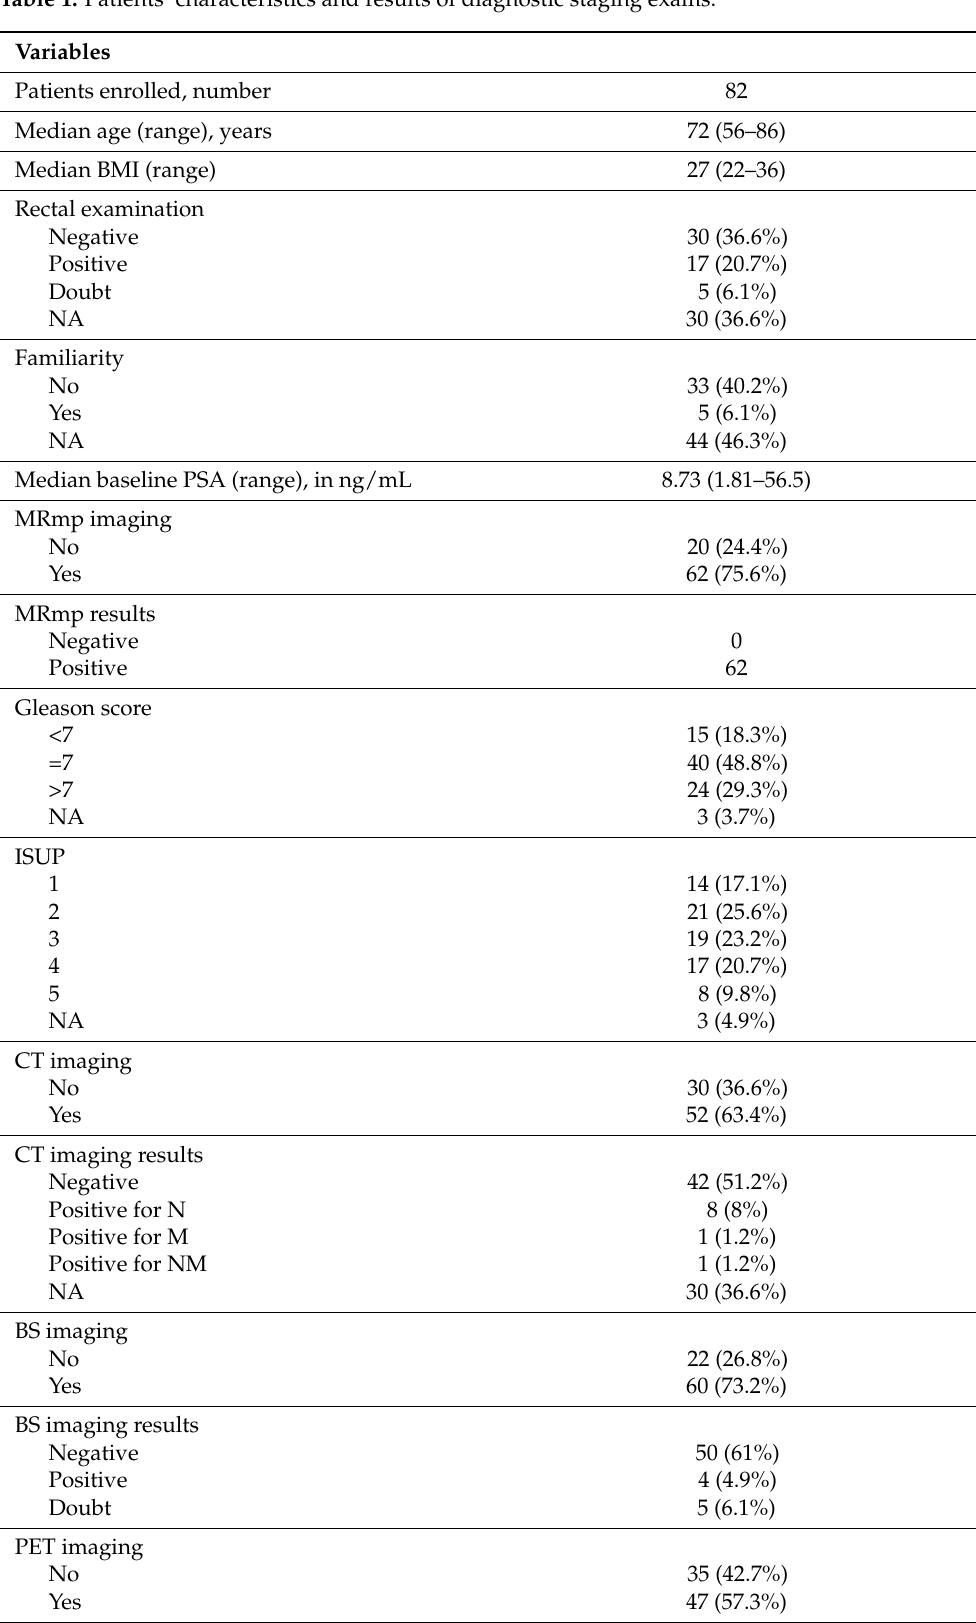
Table 1. Patients’ characteristics and results of diagnostic staging